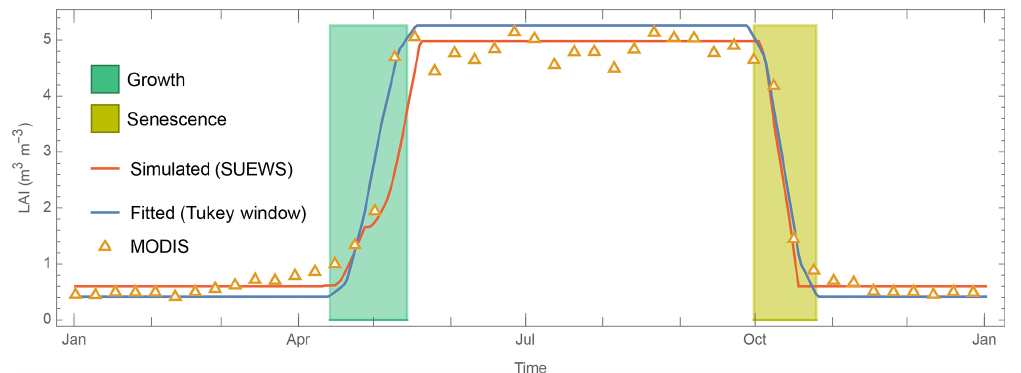
Figure 4. Intra-annual LAI dynamics at US-MMS multi-year (2002–2014) ensemble median derived from MODIS observations (open triangle, Sect. 3.2) and simulated by SUEWS temperature-based LAI scheme (Eq. 4) (orange line) with Tukey window fit (blue line, Sect. 4.1) using to derive the leaf-on or growth period (green shading) and senescence (yellow shading)